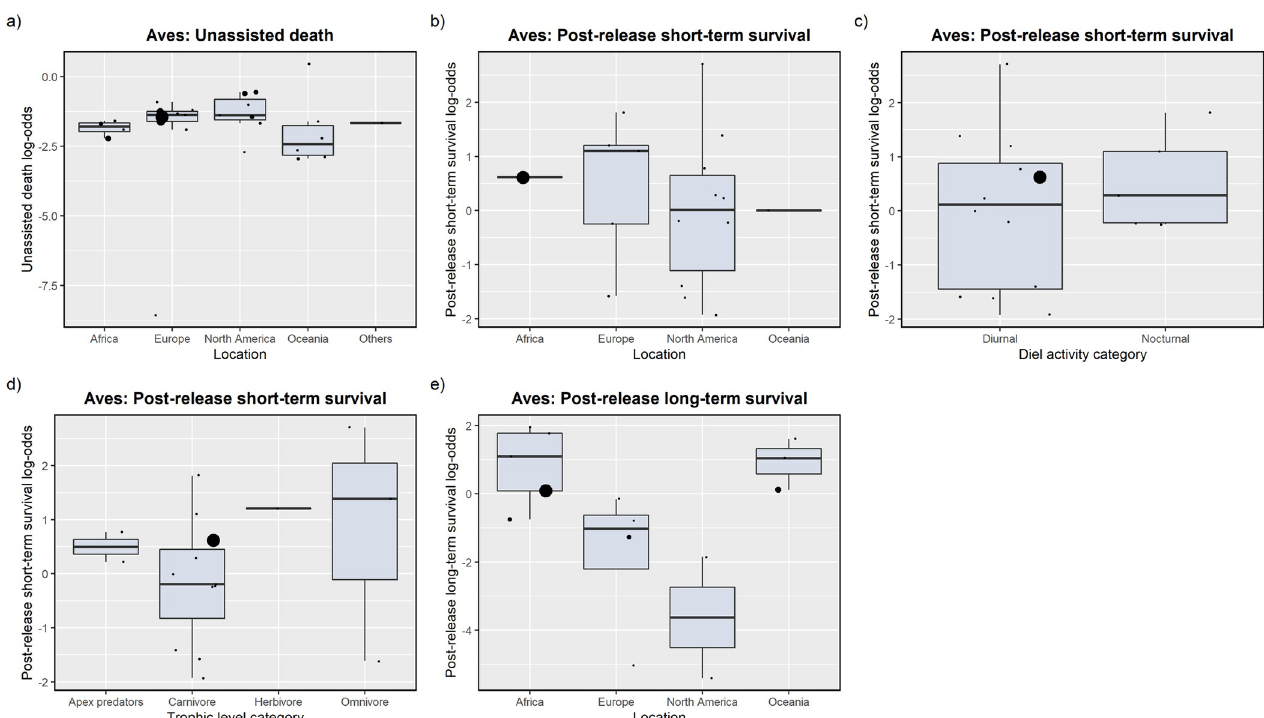
Fig 3. Distribution of log-odds across factors affecting unassisted death rates and short- and long-term post-release survival for avian species. Note that each point represents the log-odds of survival of one study-species combination, and the size of the point is proportional to the inverse variance of the log-odds (i.e. larger points have more